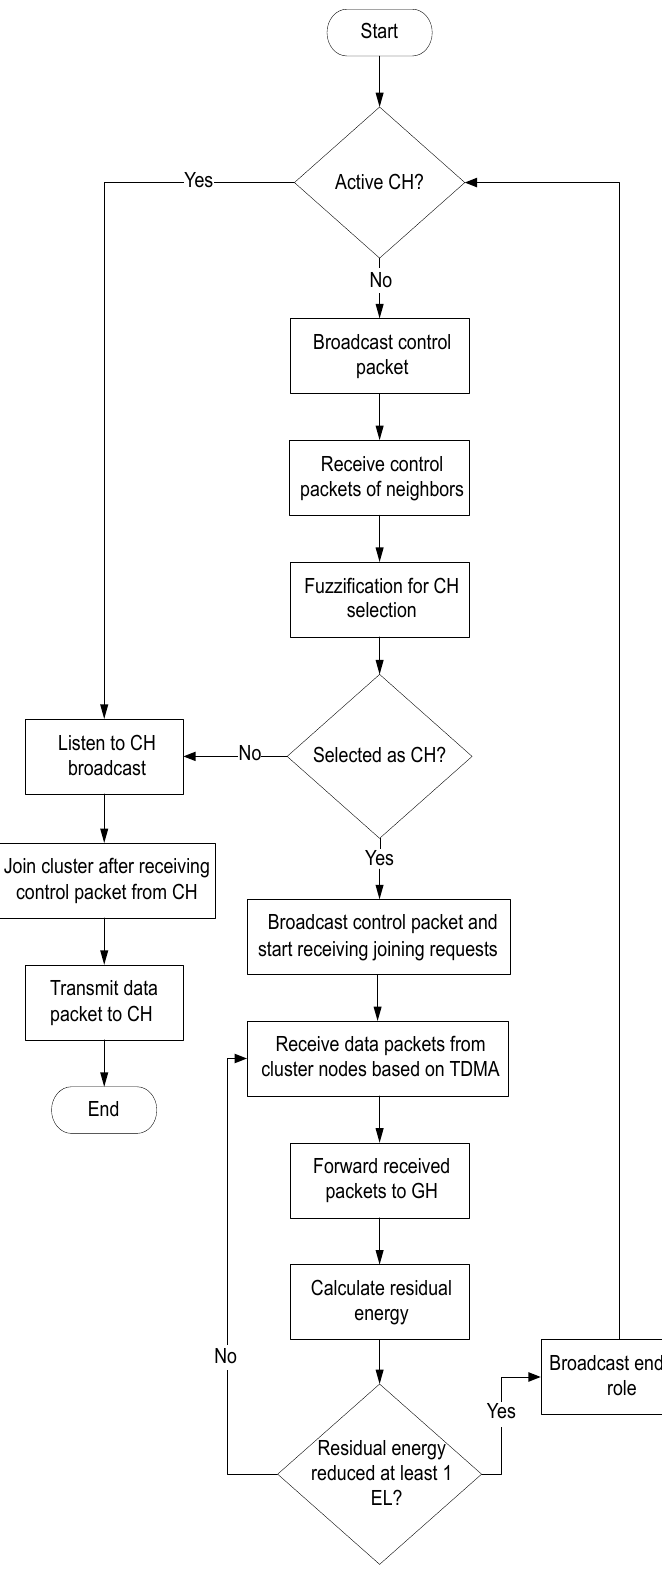
Figure 3. Cluster joining and cluster head (CH) selection process in the proposed